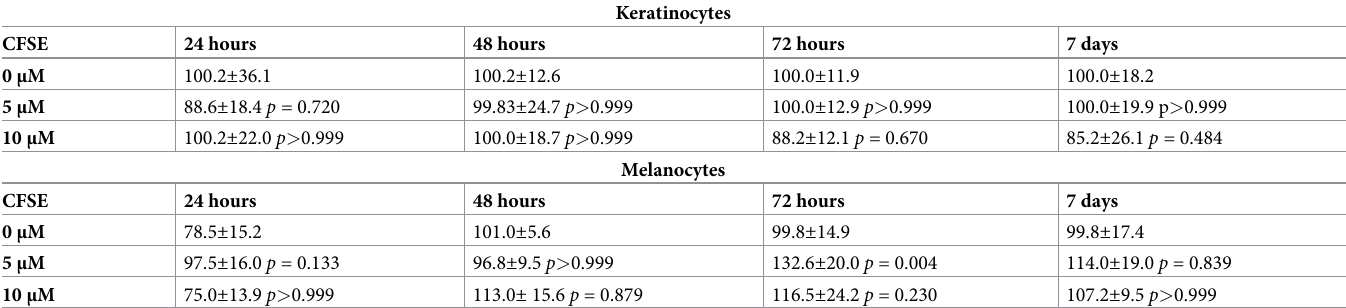
Table 2. Viability measurements using (4, 5-dimethylthiazol-2-yl)-2, 5-diphenyltetrazolium bromide (MTT) assay of primary keratinocytes and melanocytes stained with 5(6) carboxyfluorescein-N-hydroxysuccinimidyl ester (CFSE). All values reported as percent relative to unstained controls (at time 0) ± SD, with Bonferro- ni’s multiple comparisons test corrected p -values.